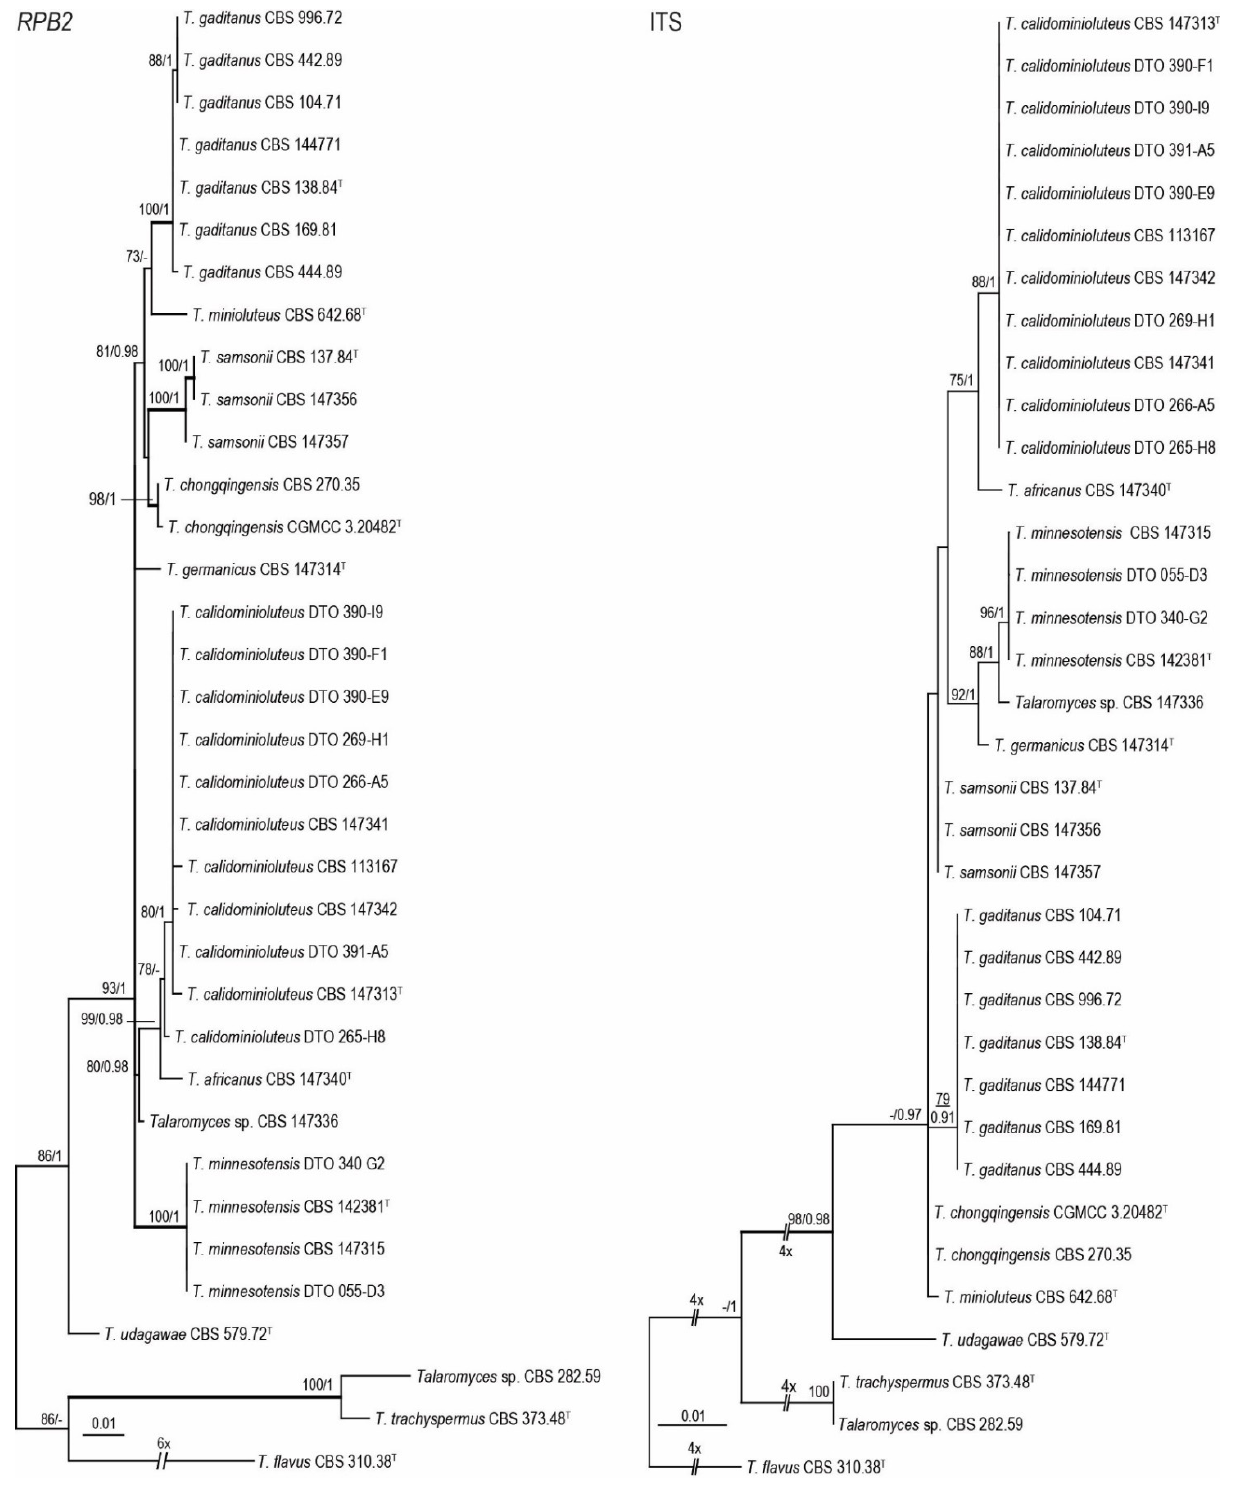
Figure 2. Maximum Likelihood (ML) tree based on ITS and RPB2 sequences depicting the relationship of T. minioluteus and related species. The BI posterior probabilities and ML bootstrap percentages are presented at the nodes (BS/PP) and the fully supported branches are thickened. Values less than 70% bs (ML) or less than 0.95 pp (Bayesian analysis) are indicated with a hyphen or not shown. The phylograms are rooted with T. flavus (CBS 310.38 T ), T. trachyspermus (CBS 373.48 T ) and Talaromyces sp. (CBS 282.59). T =